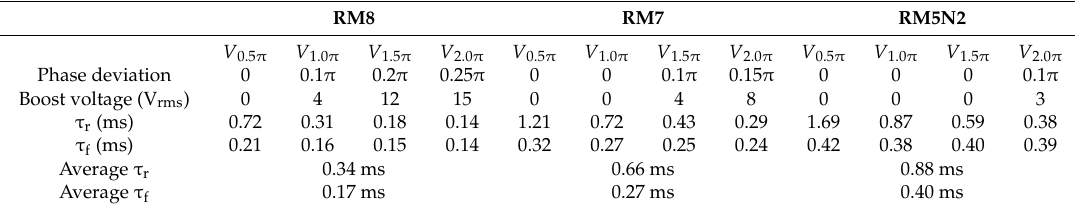
Table 3. Summary of phase deviations, response time, and the required boost voltages in three phase modulators with correct phase control.